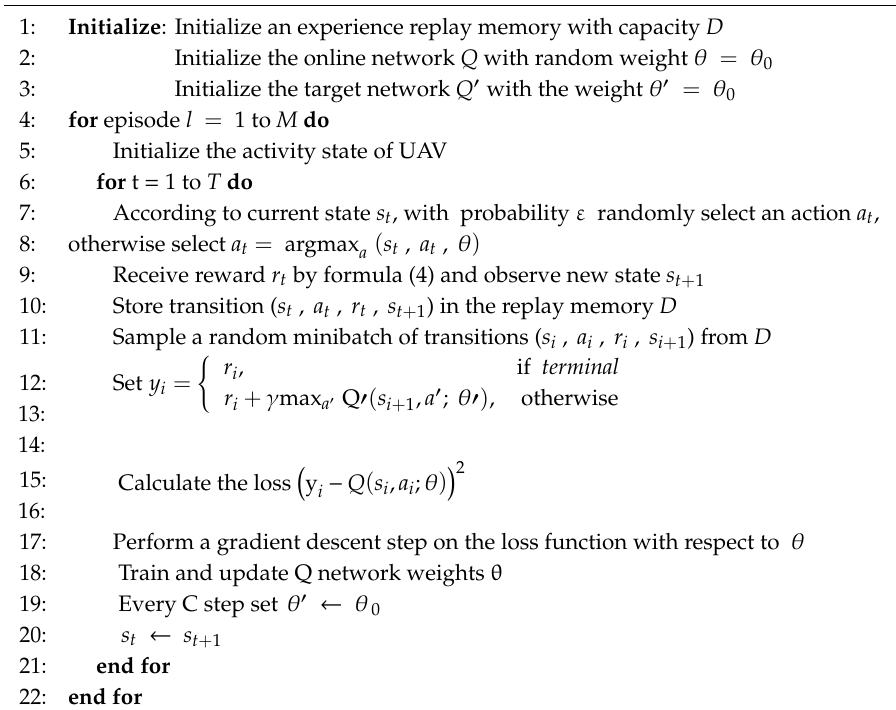
Algorithm 1 DQN-based UAV Trajectory